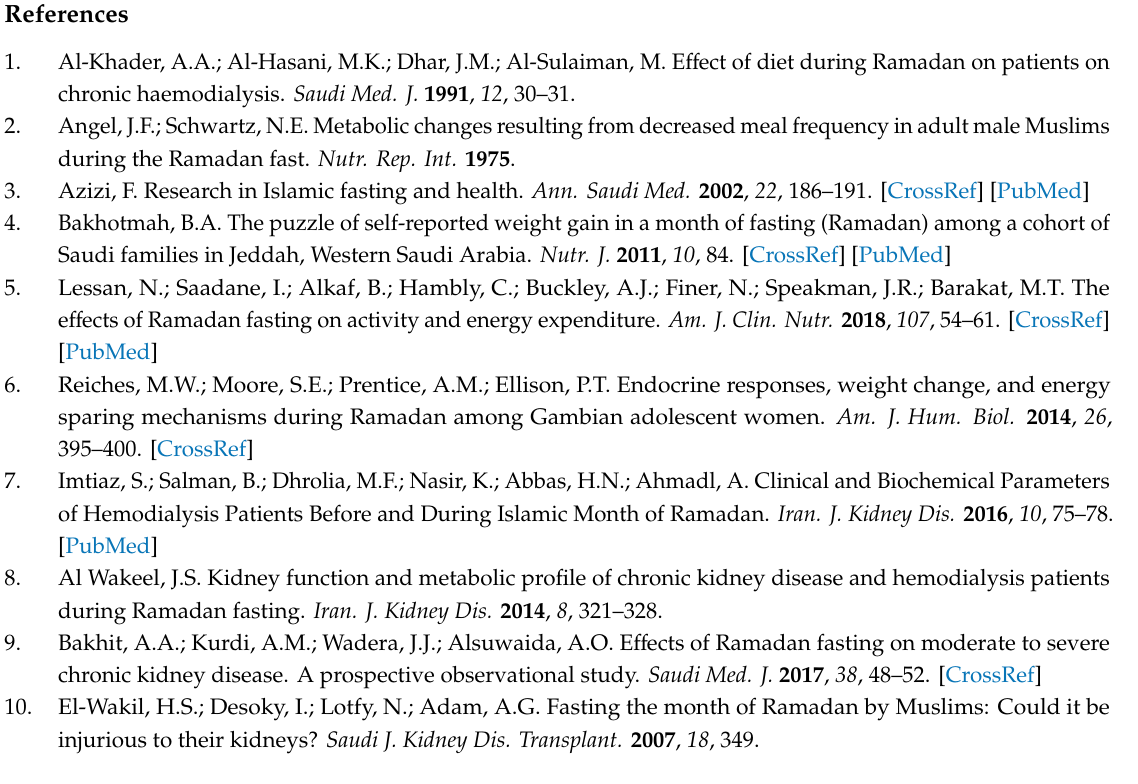
Table S1: Biochemical